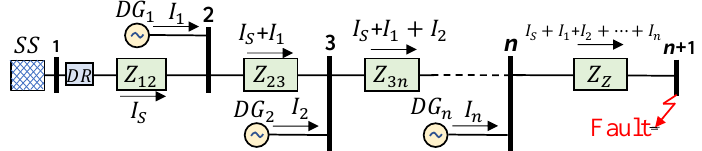
Figure 9. Radial distribution feeder with n DGs (proposed Method